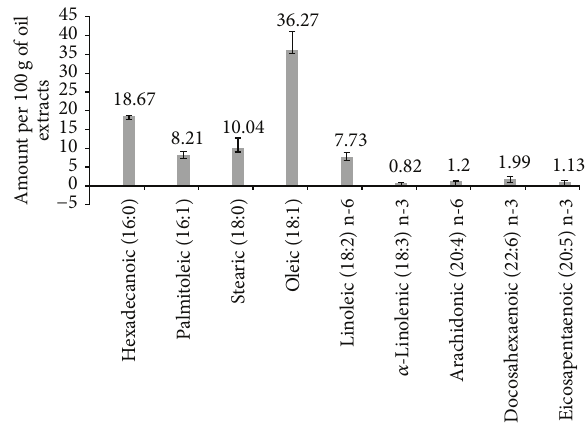
Figure 5: Lipid profile of Coturnix japonica egg yolk lipid extract. Ratio of n-6:n-3 is